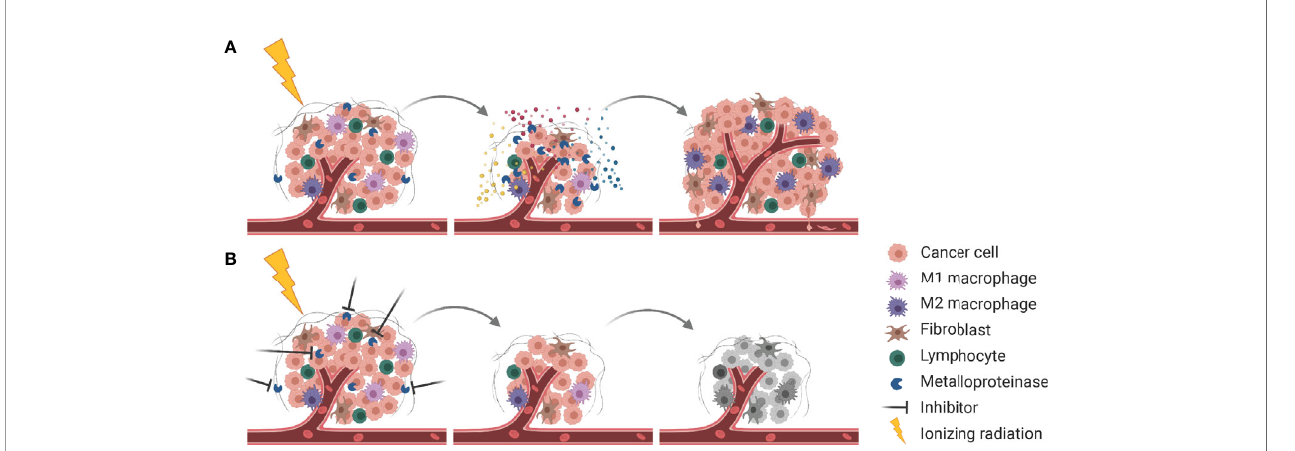
FIGURE 3 | Combining RT with metalloproteinase inhibitors for improved tumor control. (A) Next to cell killing and tumor shrinkage, RT activates metalloproteinases that release pro-survival factors (indicated in blue, red, and yellow) into the TME, resulting in tumor cell proliferation, enhanced tumor angiogenesis and pro- tumorigenic immune responses. At the same metalloproteinases disrupt the ECM barrier (gray), enabling tumor cell dissemination. (B) Combining RT with inhibition of metalloproteinases mitigates pro-survival signaling and results in more effective tumor cell